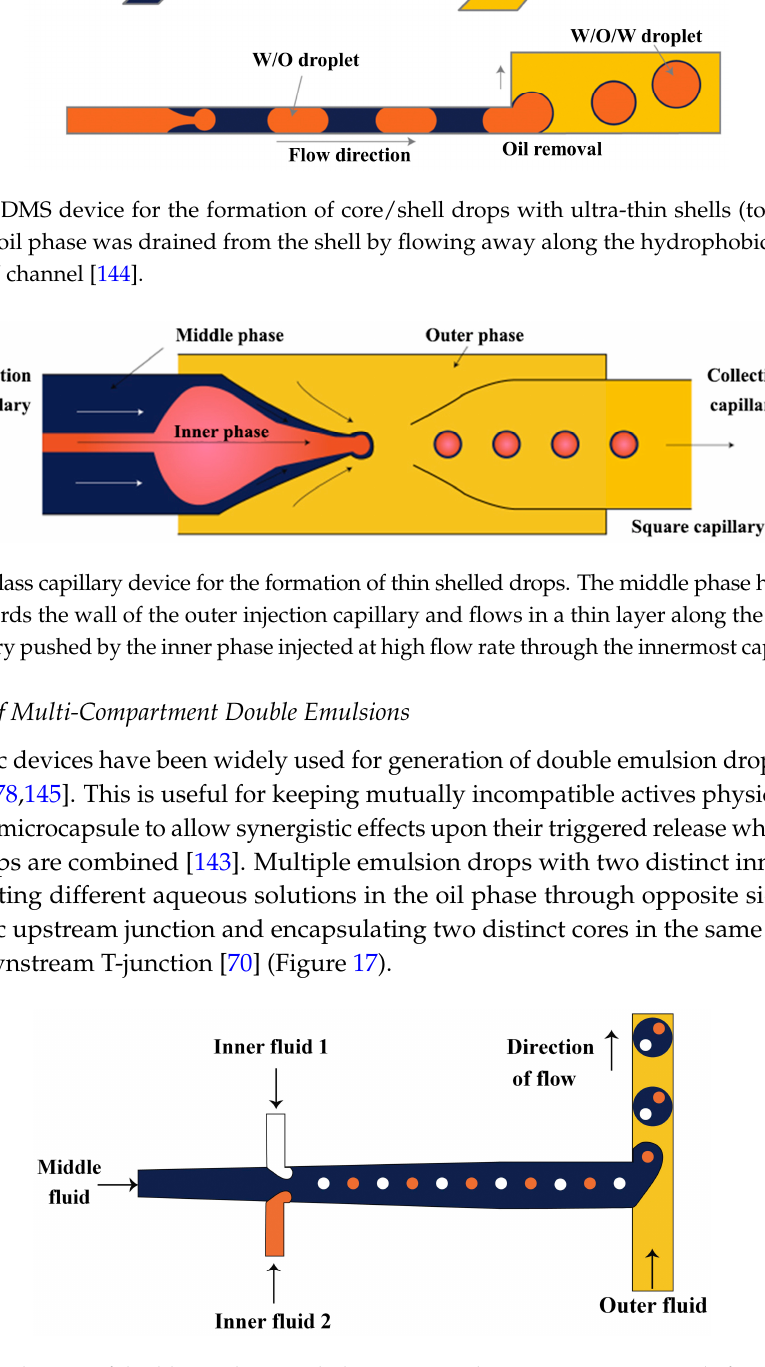
Figure 17. Production of double emulsion with distinct inner drops in a two-step emulsification process using the device consisted of one upstream cross junction and one downstream T-junction connected in series [70].